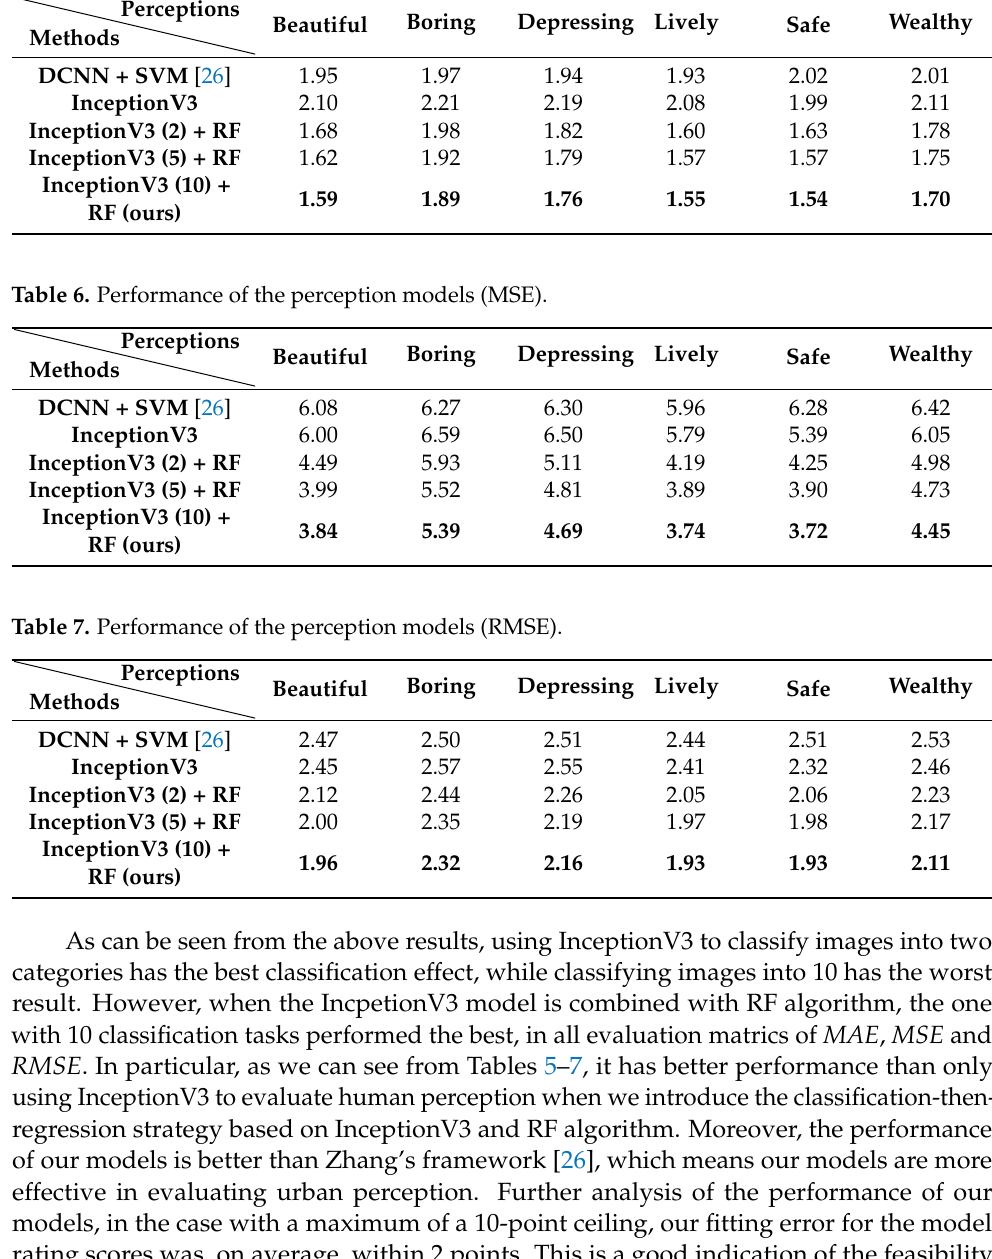
Table 5. Performance of the perception models (MAE).